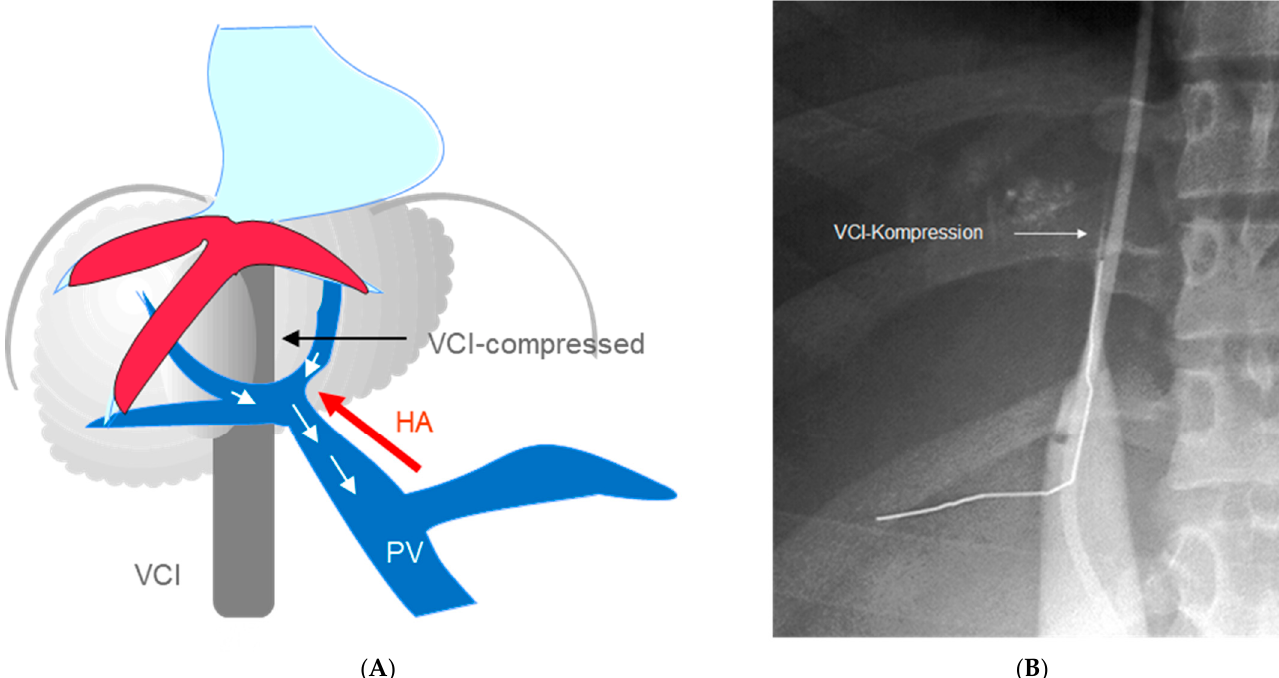
Figure 1. ( A ) Complete BCS. The portal vein is used as out fl ow tract. Enlarged caudate lobe leads to stenosis of the inferior caval vein; ( B ) Angiography of the inferior caval vein showing complete occlusion by the enlarged liver (VCI: inferior caval vein).